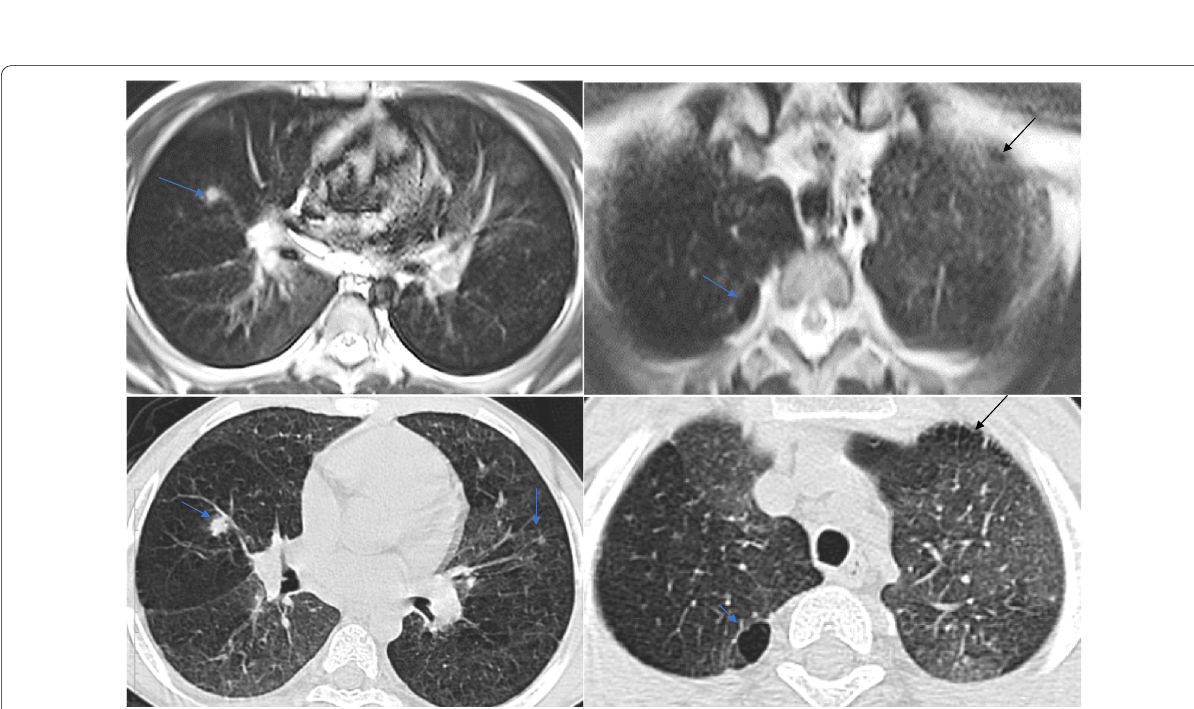
Fig. 3 A 11-year-old male with chronic airway disease secondary to autoimmune disease, T2 HASTE, and comparable HRCT cut; both show the middle lobe air trapping, bilateral nodules better delineated by CT (blue arrows), and bilateral apical subpleural blebs (black arrows). CT score 12, MRI score